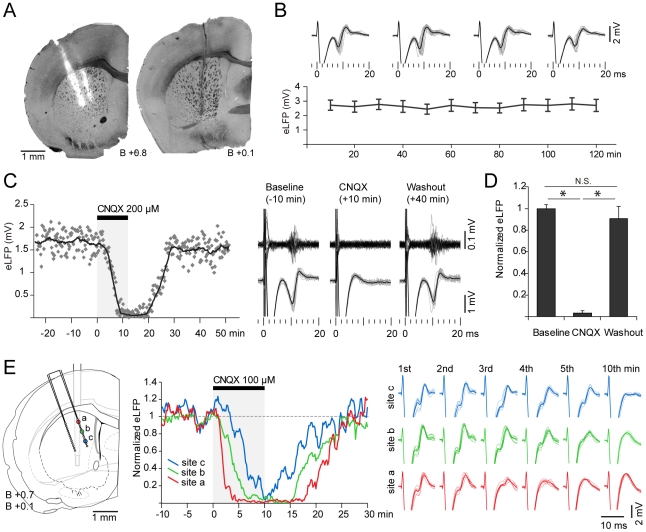
Local administration of CNQX blocks synaptic responses in the striatum.
A. Histological sections showing the location of the multichannel electrode (left) and microdialysis probe (right) in a representative experiment. B. Striatal field responses evoked by stimulating the prelimbic cortex remained stable for hours under continuous infusion of ACSF through the microdyalisis probe (n = 3). C.
Left: Time course of the blocking effect of CNQX on striatal field responses evoked by cortical stimulation in a representative experiment. Each point is the amplitude of a single evoked response, which was evaluated every ten seconds during the experiment. The superimposed line corresponds to the smoothed data with a moving average window (20 samples). Right: Field potential responses corresponding to the individual trials depicted in gray, and multiunit activity recorded from the same electrode contact, before, after 10 minutes of CNQX infusion, and after 40 minutes of washing out with ACSF. Data are from the experiment shown at the left. D. CNQX administration (200 µM) almost completely blocked the striatal field response to cortical stimulation (* p<0.001, Tukey post-hoc test, repeated measures ANOVA, N = 4). E.
Left: Histological reconstruction showing the location of three recording sites in the multichannel electrode (a, b, c) and the microdialysis probe in one of the CNQX experiments. Middle: Time course of CNQX effect at sites a, b and c. Note that CNQX reached first the closest recording site a than the more distant sites b and c. Distance between illustrated recording sites: 400 µm. Right: Striatal field response during the first 5 minutes and at the 10th minute of CNQX infusion in the same experiment, showing that by the fourth minute, response in site a was abolished but remained almost unchanged 800 µm away in site c. Note that the time course of CNQX effect depends on the location of the recording electrode and not on the basal amplitude of the response (compare site a with site c).